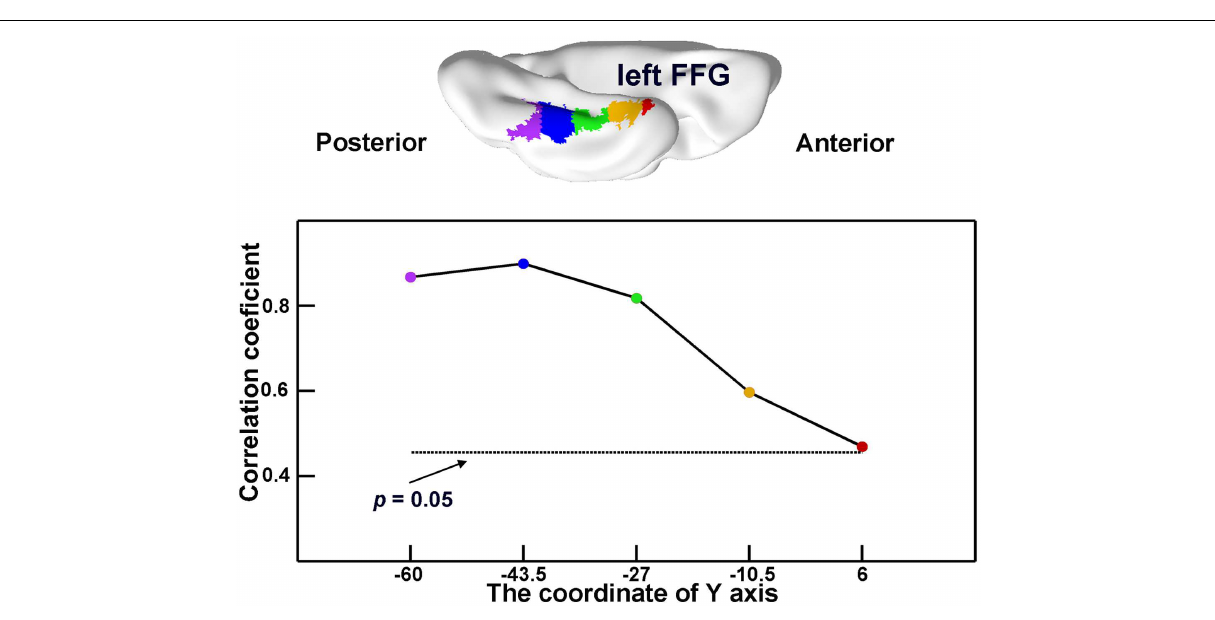
FIGURE 4 | The semantic-relevant effects across different portions of the left fusiform gyrus (lFFG). The lFFG was first evenly split into five subregions along the y -axis (top) . Then, the GMVs of each subregion were correlated with the semantic composite scores across SD subjects (bottom) . The horizontal dotted line shows the threshold for significance for the correlation coefficients ( p <